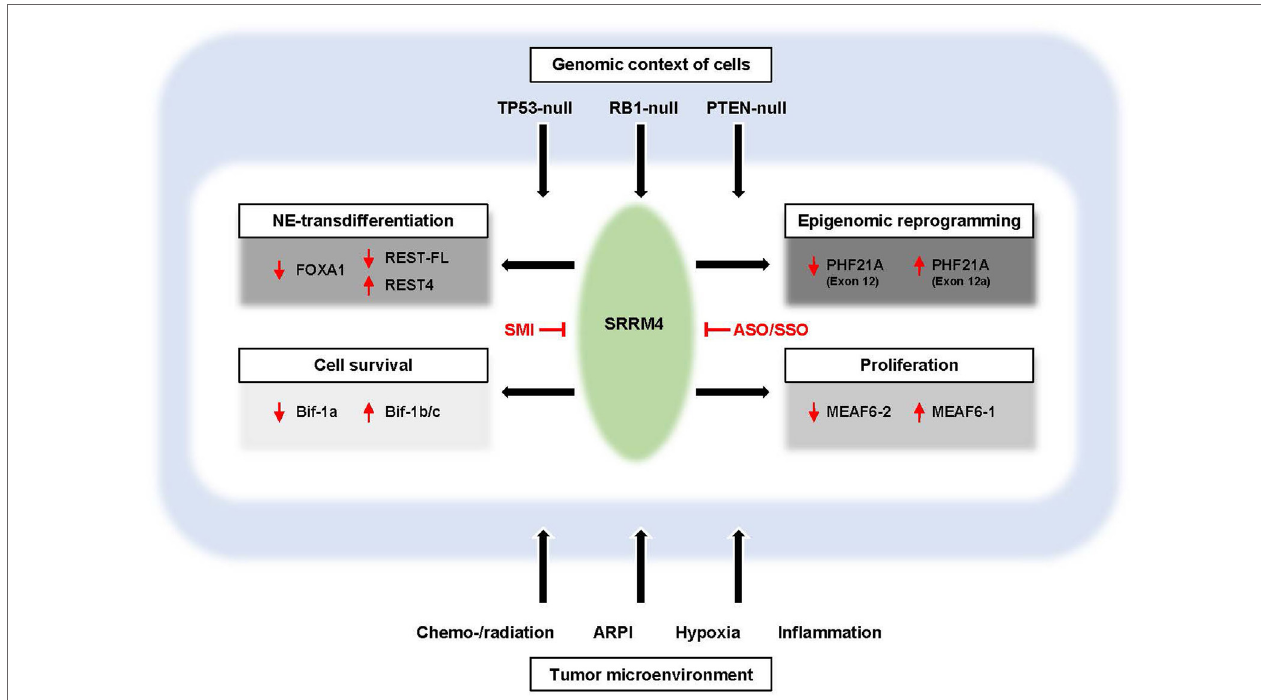
FiGUre 1 | Development of NEPC by the SRRM4-mediated RNA splicing network. The multifaceted roles of SRRM4 and SRRM4-mediated alternative RNA splicing of genes highly enriched in neuronal functions drives a CRPC-NE program via various aspects important for CRPC-NE progression. SRRM4-mediated spliced variants not only facilitate the NE-transdifferentiation of CRPC-Ad cells possibly through epigenetic alterations but also promotes cancer cell survival, proliferation, and tumorigenesis of CRPC-NE cells to establish CRPC-NE tumors. We propose that SRRM4 may function beyond its putative role in RNA splicing via mechanisms involving transcriptional factors (e.g., FOXA, REST, and AR), tumor suppressors (e.g., RB1 and p53), and microenvironment factors (e.g., therapeutics, hypoxia). Potential SRRM4-targeted therapeutic approaches for treating CRPC-NE or mitigating its development may be to inhibit the splicing or RNA-binding activity of SRRM4 via SMI or target the alternative splicing events via ASO. This multi-functional property of SRRM4 ultimately provides cancer cells the ability to develop therapy resistance and develop into CRPC-NE tumors. SMI, small molecule inhibitors; ASO, antisense oligonucleotides; SSO, splice-switching oligonucleotides; ARPI, androgen receptor pathway inhibition; CRPC-Ad, castration-resistant adenocarcinoma prostate cancer; NEPC, neuroendocrine prostate cancer; SRRM4, Ser/Arg repetitive matrix